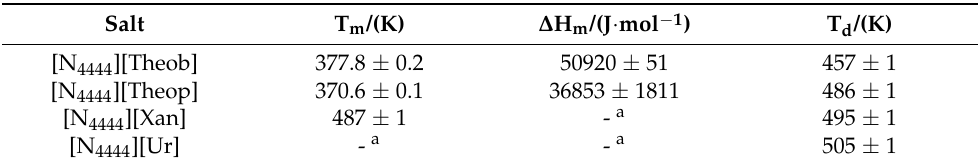
Table 2. Melting temperature (T m ), melting enthalphy ∆ H m , and decomposition temperature (T d ) of the purine-based